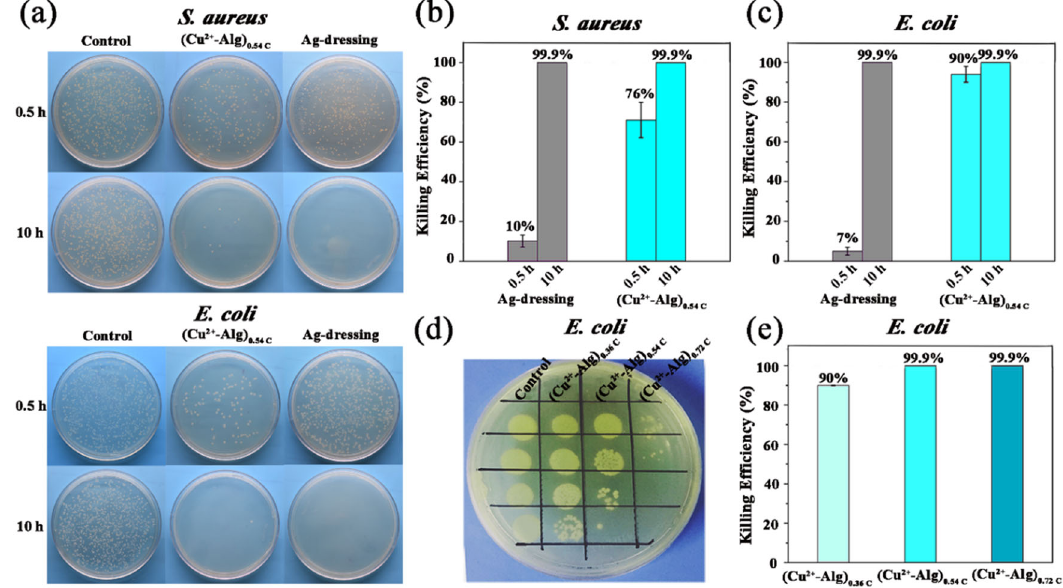
Fig. 3 In vitro antimicrobial activities. a Photographs of S. aureus and E. coli colonies on the ager plate after incubation with different samples and gradient dilution. b Bacterial killing ef fi ciency of (Cu 2 + - Alg) 0.54C and commercial Ag dressing against S. aureus and c E. coli . d Photographs of E. coli colonies on the ager plate after